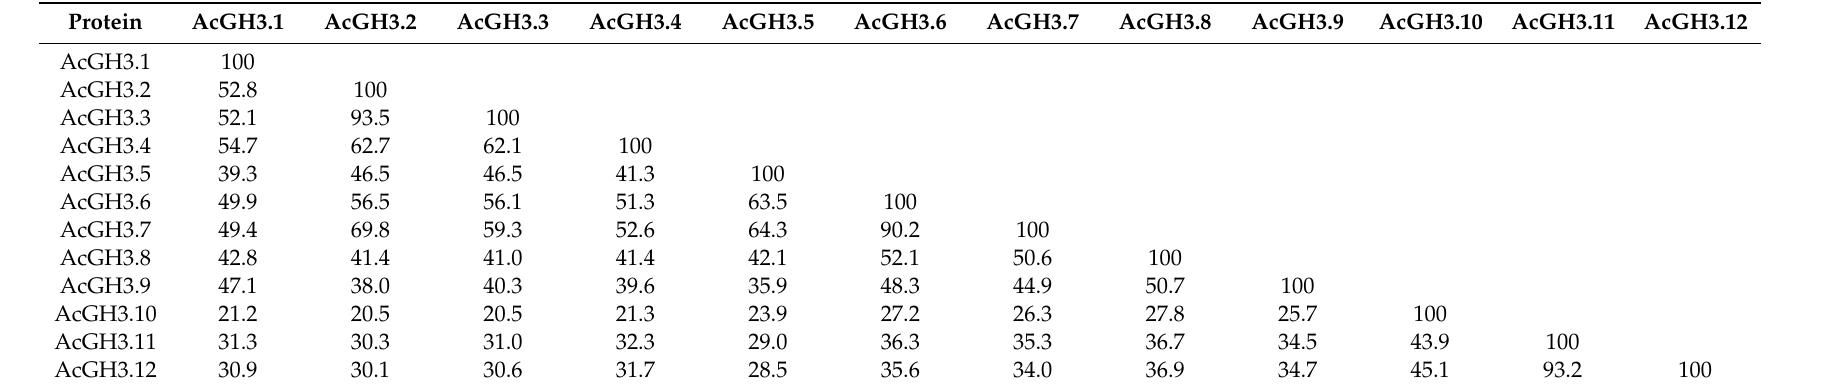
Table 2. Pairwise comparison of amino acid identity (%) of 12 AcGH3